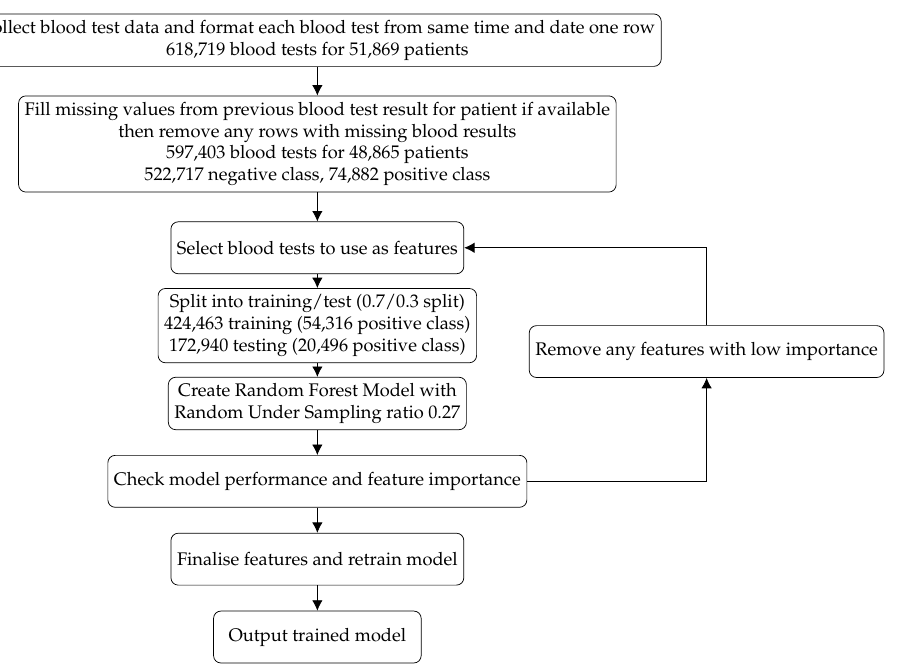
Figure 1. Flow diagram of the data process. The process the data went through from creation to the output model including training/test split and removed data. Feature selection was an iterative process using recursive feature elimination, as shown in the flow